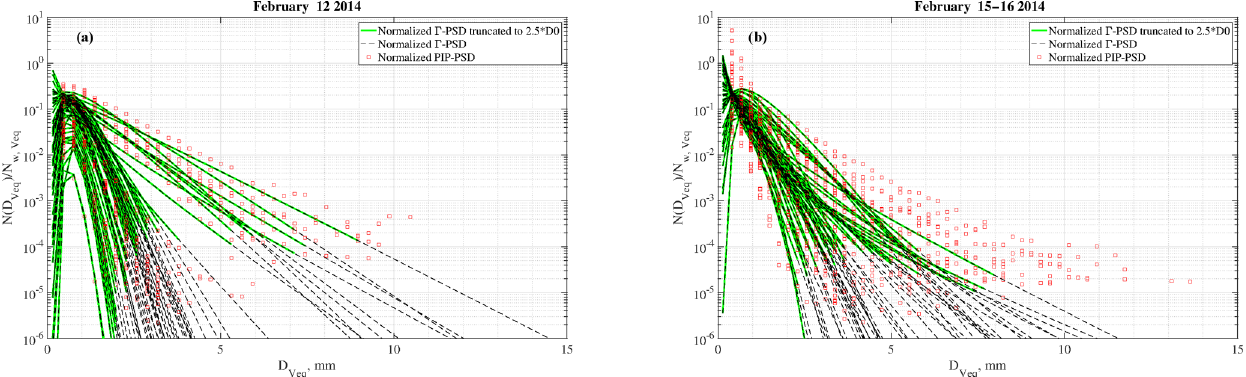
Figure 13. Panel (a) shows PSD for snowfall case of 12 February 2014 and (b) shows PSD for snowfall case of 15/16 February 2014. Red circles are representative of the normalized PSD measured by PIP, the dashed black line represents the normalized estimated (cid:48) -PSD in Eq. (4) and the green line is the last one truncated at the maximum value of 2.5 multiplied by the median diameter D 0